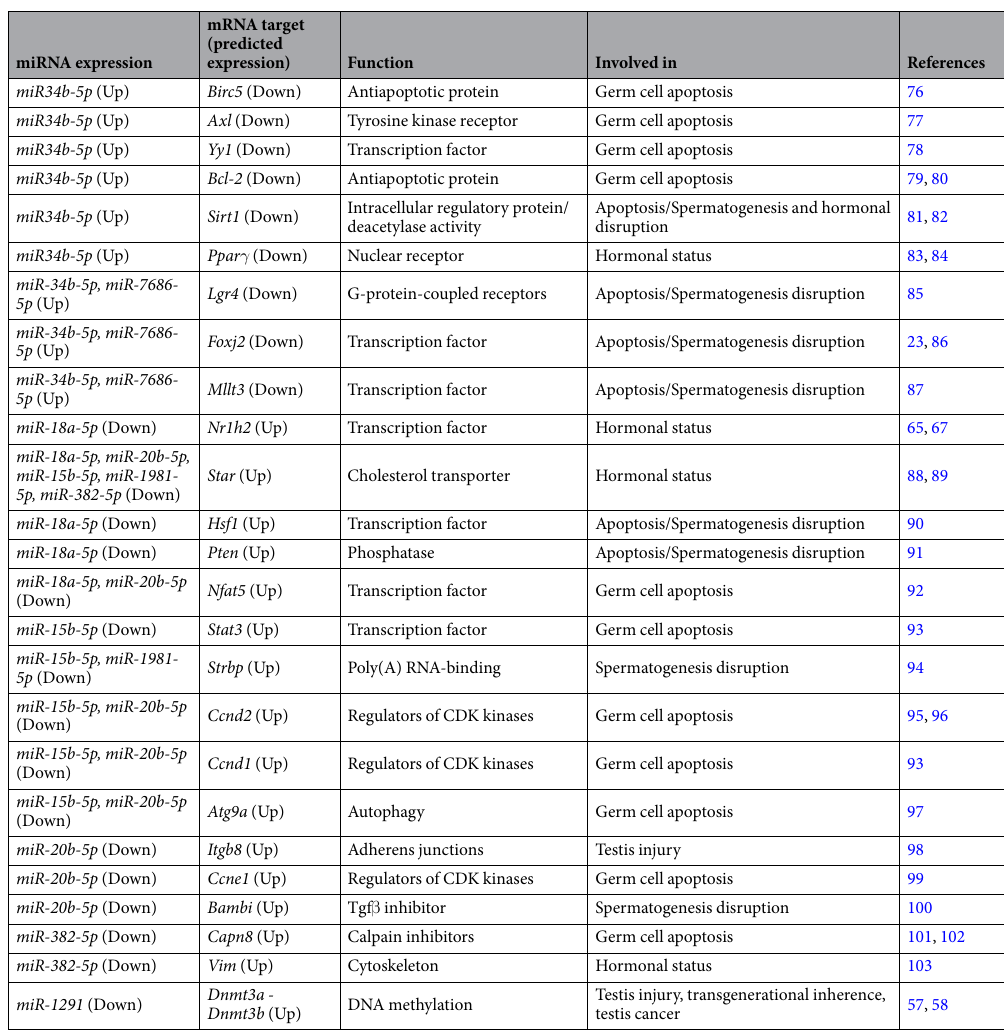
Table 3. Differentially expressed miRNAs are associated with selected target genes in testes of mice exposed to the mixture of EDCs. Target predictions of miRNAs were done using IPA and miRWalk. Function and biological process involvement in the testes for each target gene were recorded from references in the